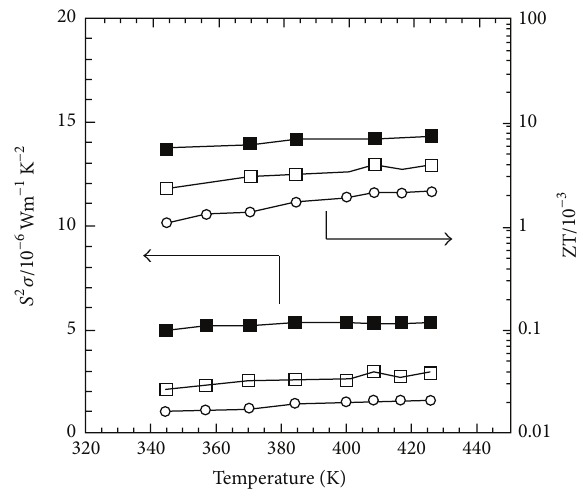
Figure 6: Thermoelectric power factor and ZT of CSA-doped stretched polyaniline films at various temperatures. Unstretched film ( I ) , stretched film perpendicular (◻) , and parallel (◼) to the stretching direction